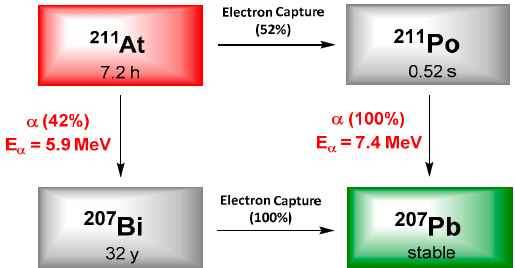
Figure 3. Simplified decay scheme of 211 At.